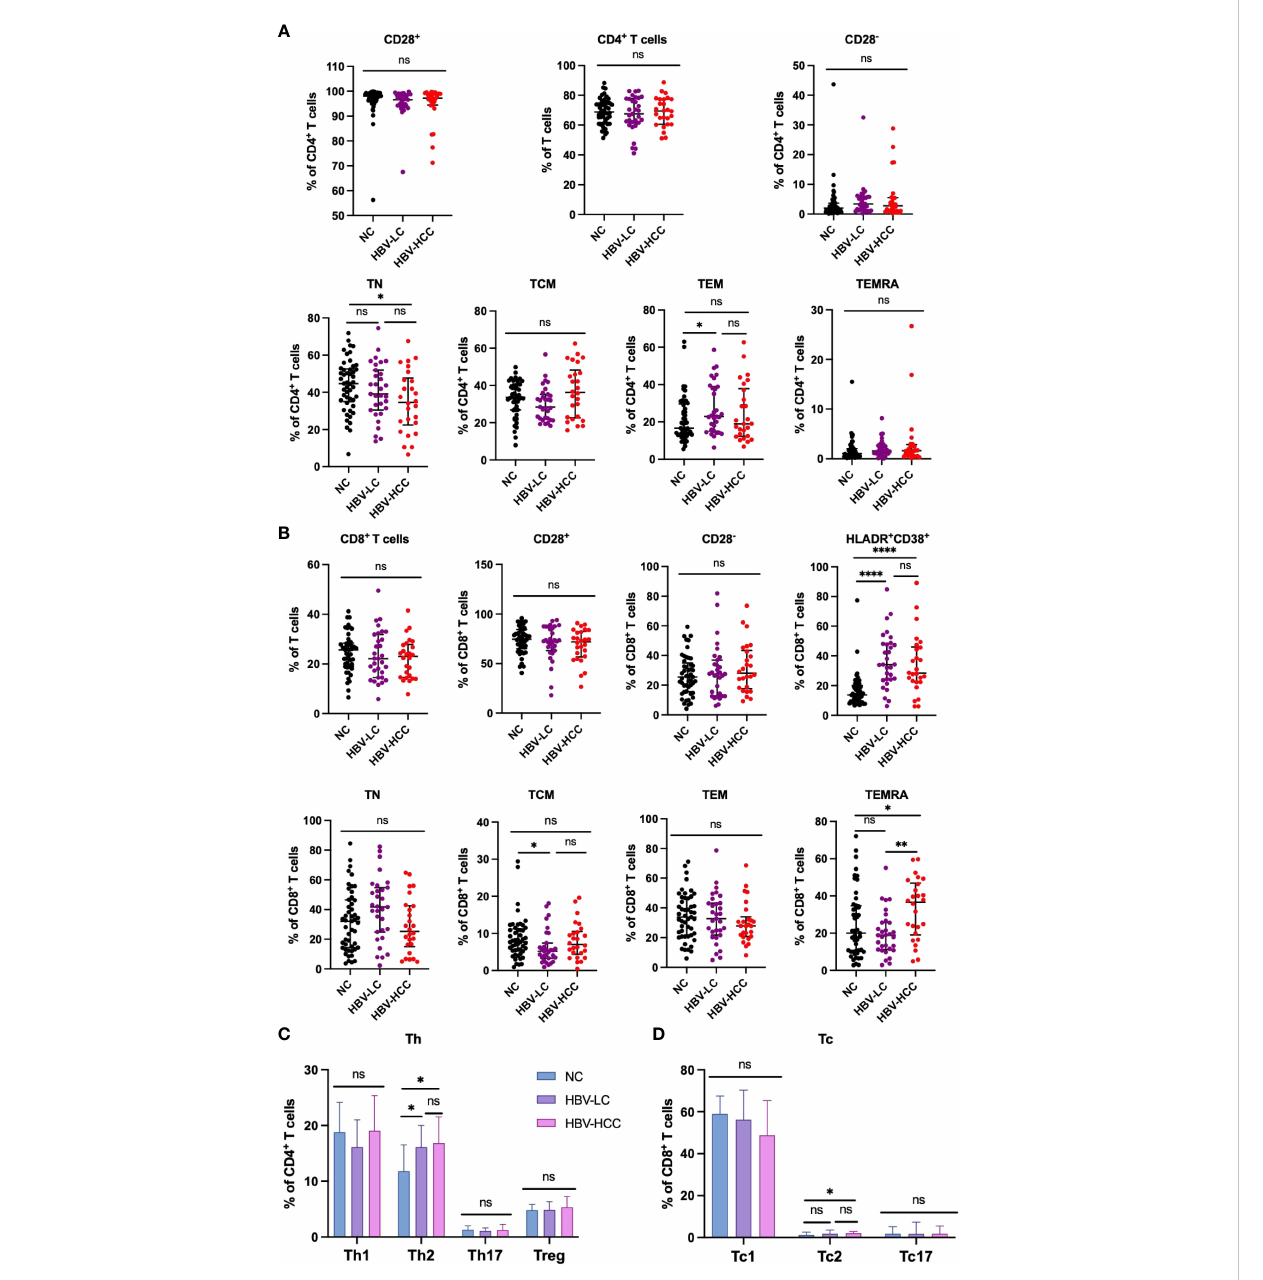
FIGURE 2 Frequency of circulating ab T cells and subsets in healthy volunteers 、 HBV-LC and HBV-HCC patients. (A) According to the expression of co- stimulatory molecule CD28, CD4 + T cells can be divided into functional cells (CD28 + ) and exhausted cells (CD28 - ), proportion of TN, TCM, TEM and TEMRA subsets of CD4 + T cells. (B) According to the expression of co-stimulatory molecule CD28, CD8 + T cells can be divided into functional cells (CD28 + ) and exhausted cells (CD28 - ), proportion of TN, TCM, TEM and TEMRA subsets of CD8 + T cells. Marker of activation HLADR and CD38 were stained to determine the homing memory CD8 + T cells. (C) The frequency of Th1, Th2, Th17, Treg cells in CD4 + T cells. (D) The frequency of Tc1, Tc2 and Tc17 cells in CD8 + T cells. The ANOVA or Kruskal-Wallis test was used to determine statistical differences between the three groups. * p <0.05, ** p <0.01, **** p <0.0001. ns, not signi fi